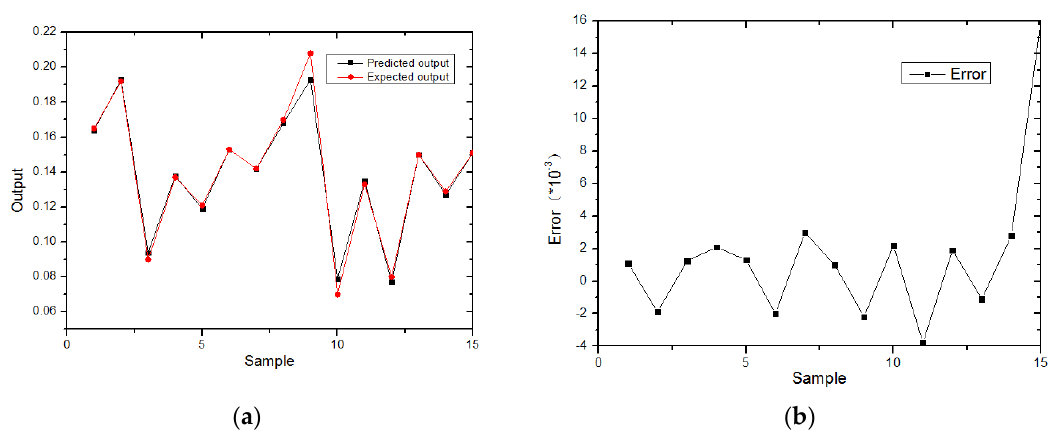
Figure 2. ( a ) The predicted output; ( b ) The error (Source: own work). Table 4. Optimal indicator